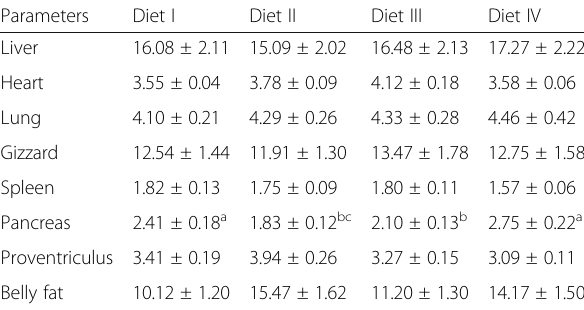
Table 6 Organ weight (g/kg body weight) of broiler chickens fed with diets containing fortified bread waste meals Parameters